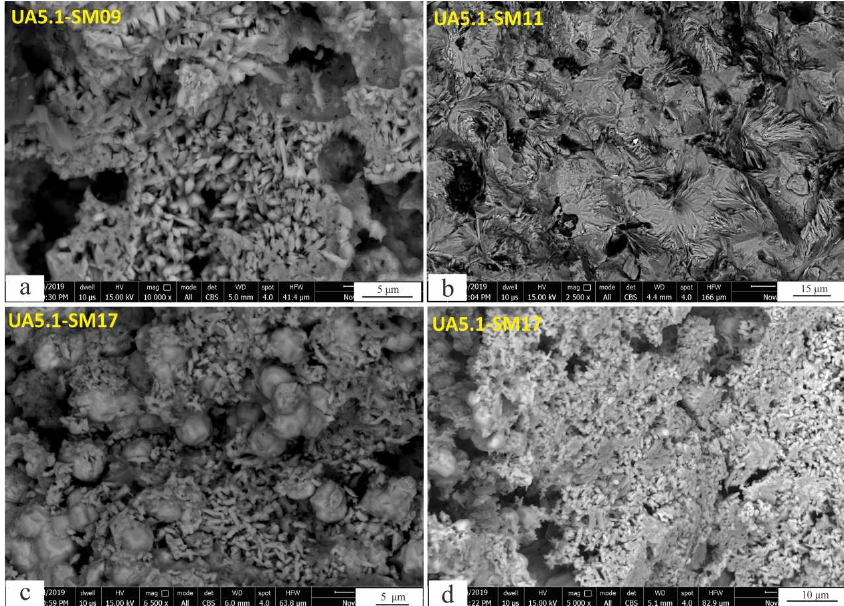
Figure 6. SEM characteristics of ferruginous sandstone of Wajid Group. ( a ) UA5.1/SM09: granular ferrous oxide aggregate; ( b ) UA5.1/SM11: filamentous ferrous oxide; ( c ) UA5.1/SM17: spherical and granular ferrous oxide aggregate; ( d ) UA5.1/SM17: granular ferrous oxide aggregate.